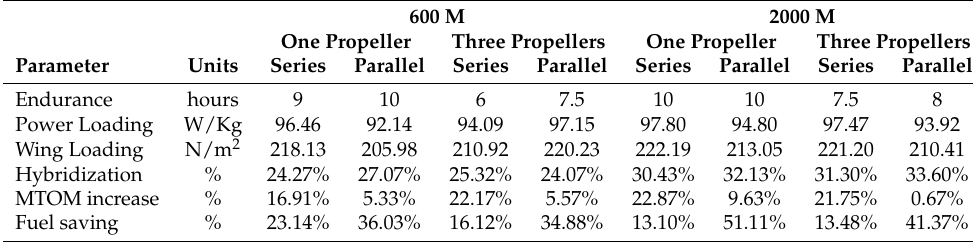
Table 7. Results of best